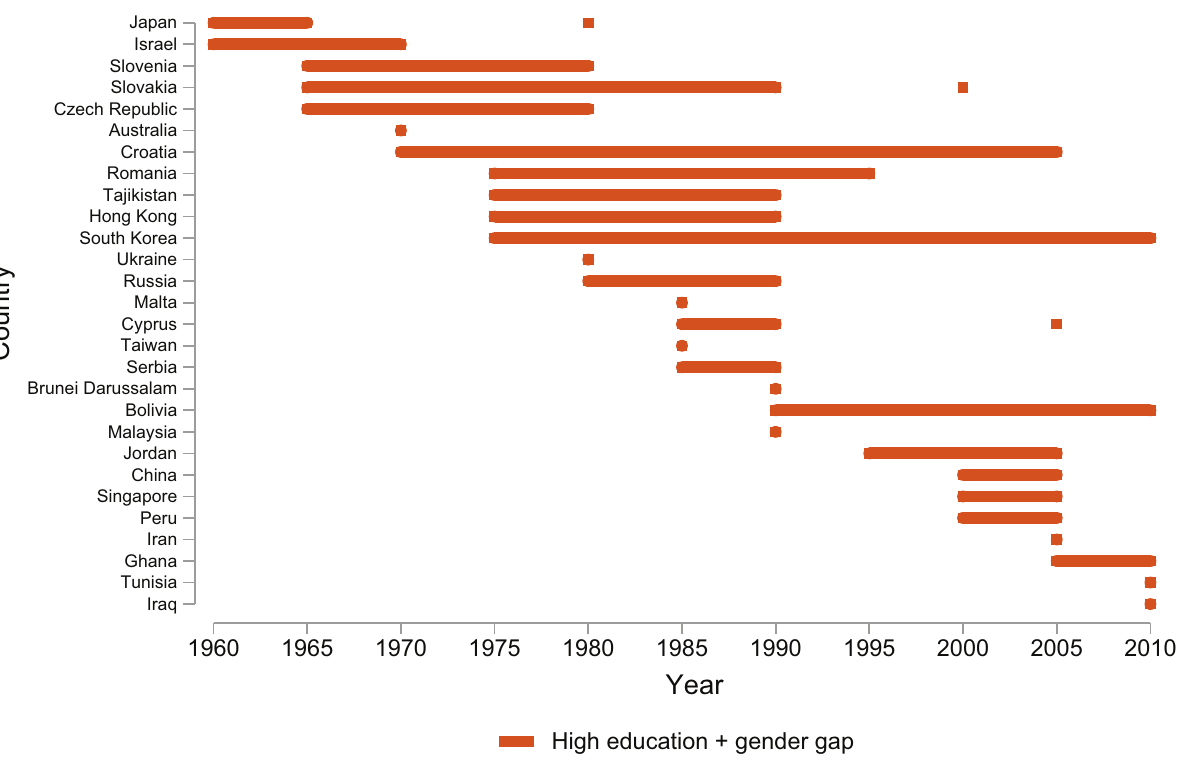
Countries' Transition to and from the High Education and Big Gender Gap